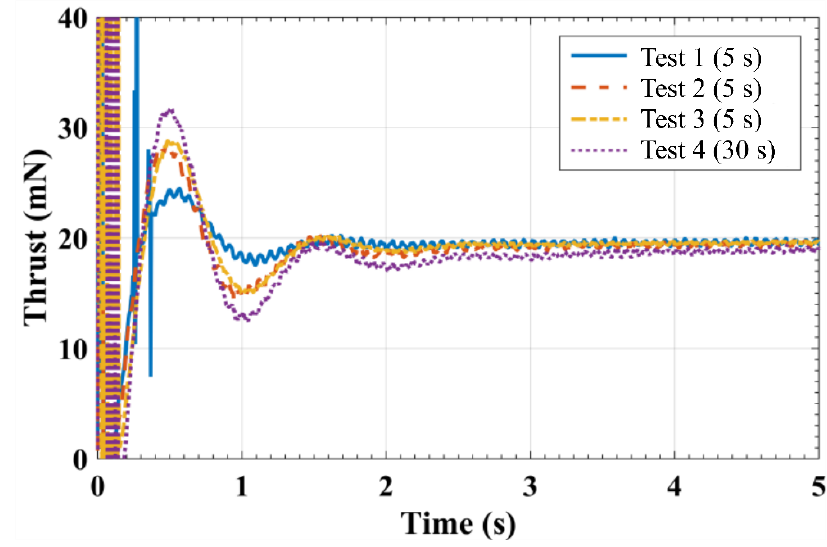
Figure 10. Repeat tests at 200 V and 1.82 mg/s anode mass flow.